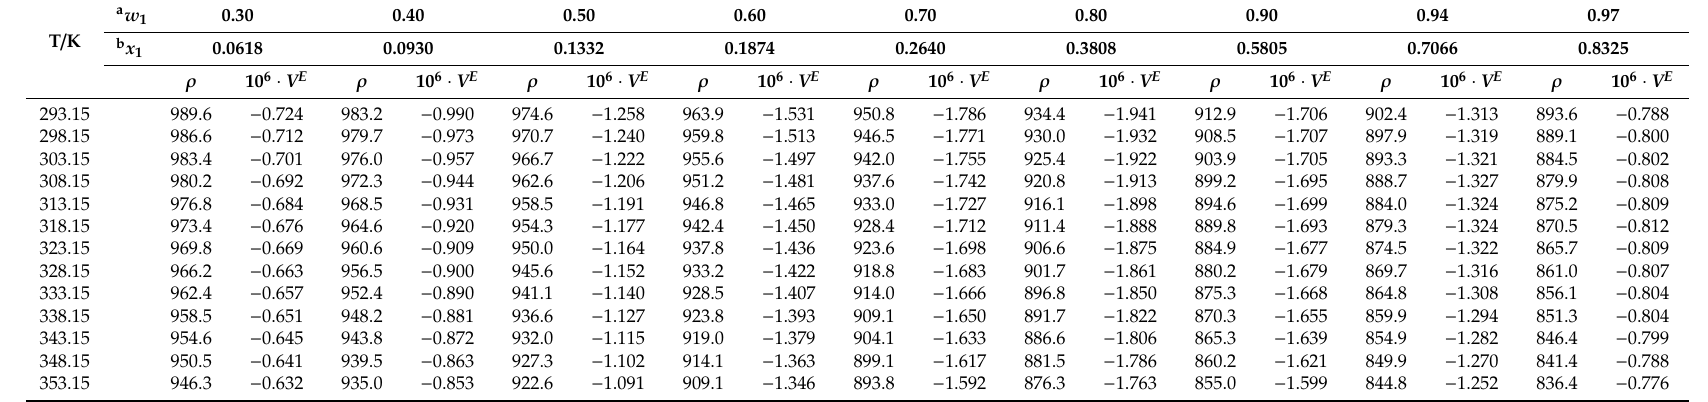
Table A3. Measured density ( ρ / kg · m − 3 ) and deduced excess molar volume ( V E / m 3 · mol − 1 ) of DEEA (1) + H 2 O (2) mixtures.